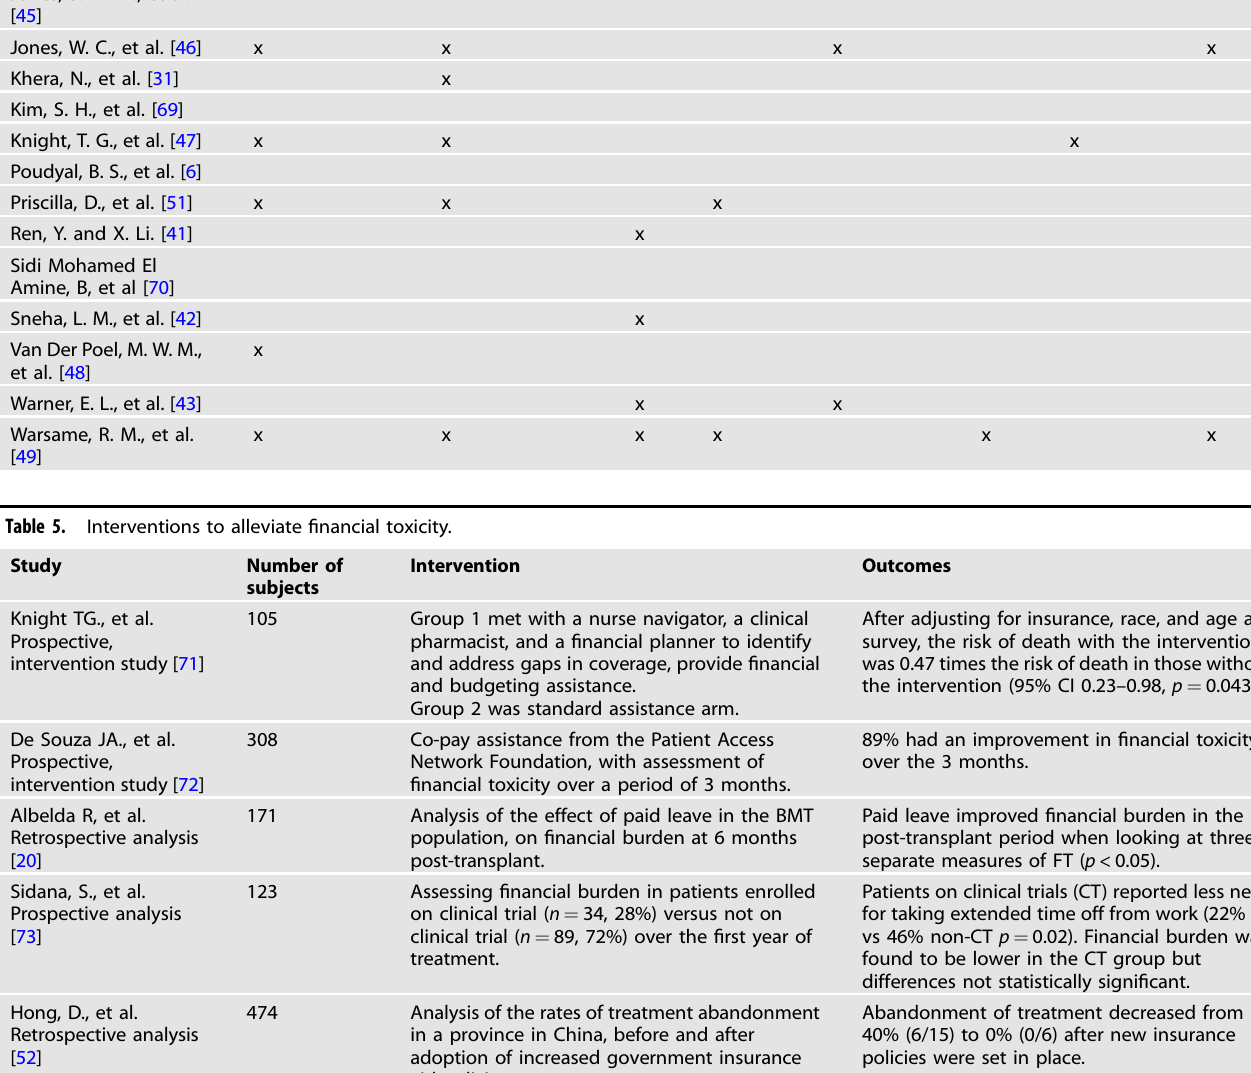
Assessing fi nancial burden in patients enrolled on clinical trial ( n = 34, 28%) versus not on clinical trial ( n = 89, 72%) over the fi rst year of treatment. Analysis of the rates of treatment abandonment in a province in China, before and after adoption of increased government insurance aid policies.